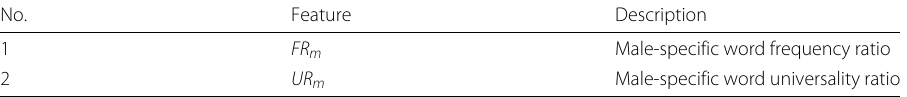
Table 2 Gender-specific thesaurus-based feature